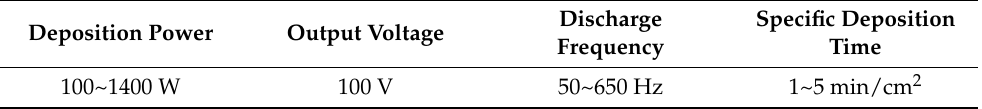
Table 2. ESD process parameters.